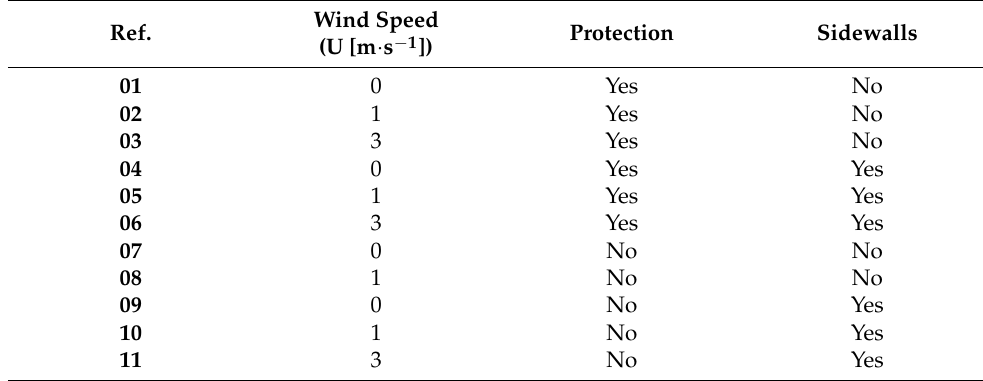
Table 2. Conditions of the experimental tests performed.